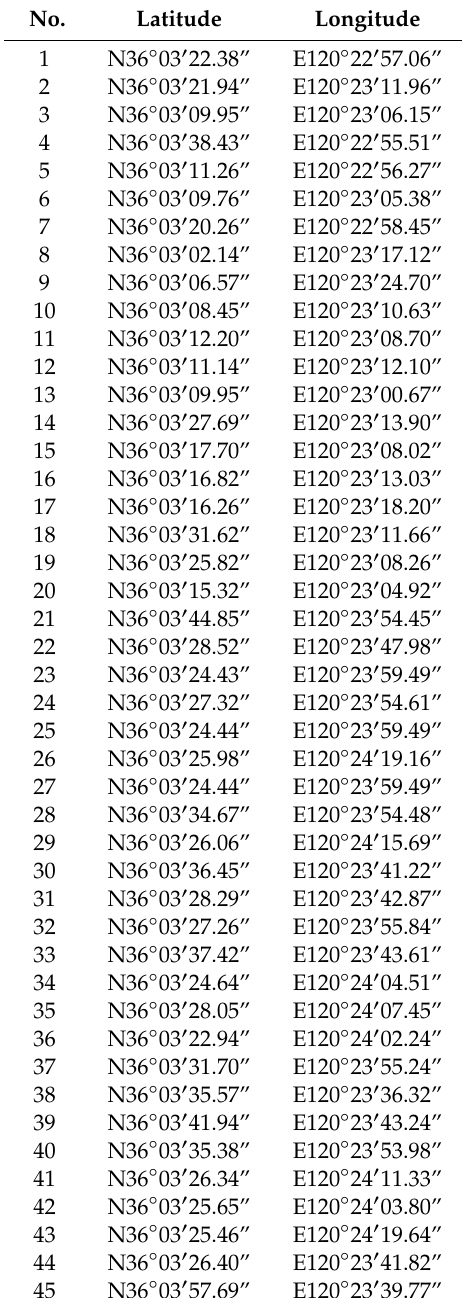
Table A4. Location coordinates of 45 planned